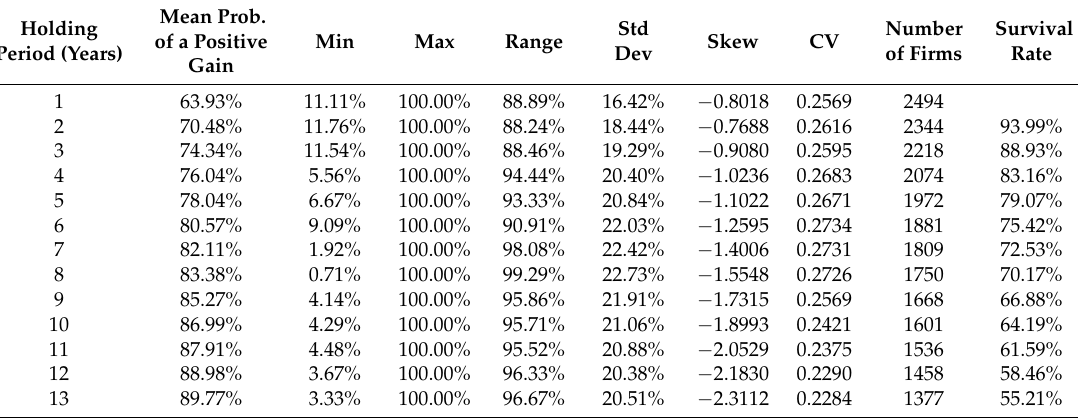
Table 8. NYSE Company Probabilities.